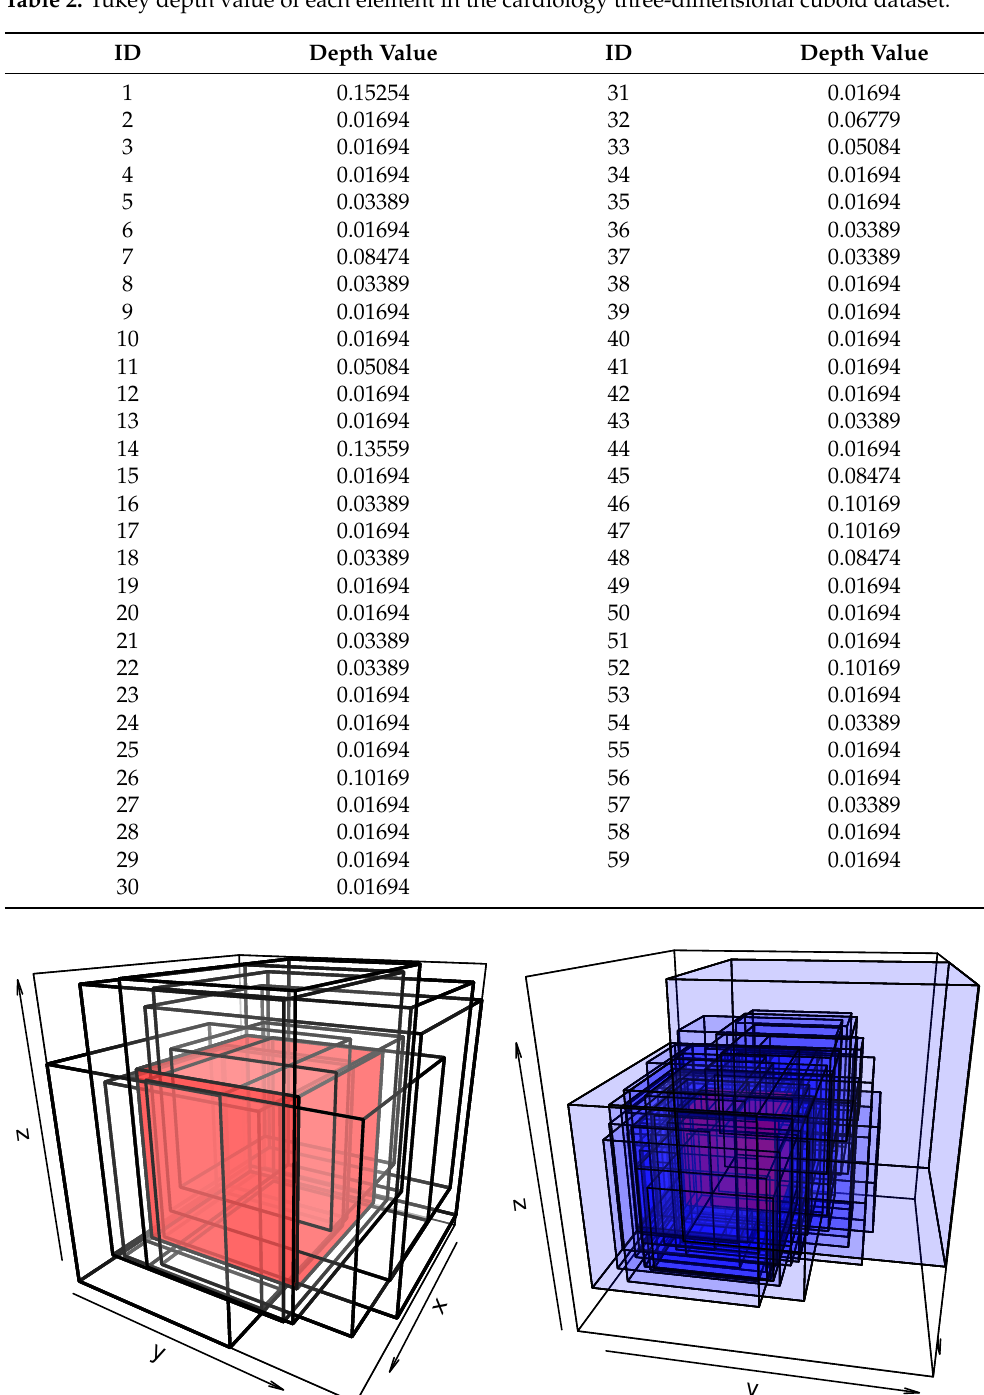
Figure 2. Representation of the sets with maximum and minimum depths. The left panel represents the five sets of maximum depth with the deepest one, C 1 , in red. The right panel represents the sets with minimum depth, in (18), and again the set C 1 in